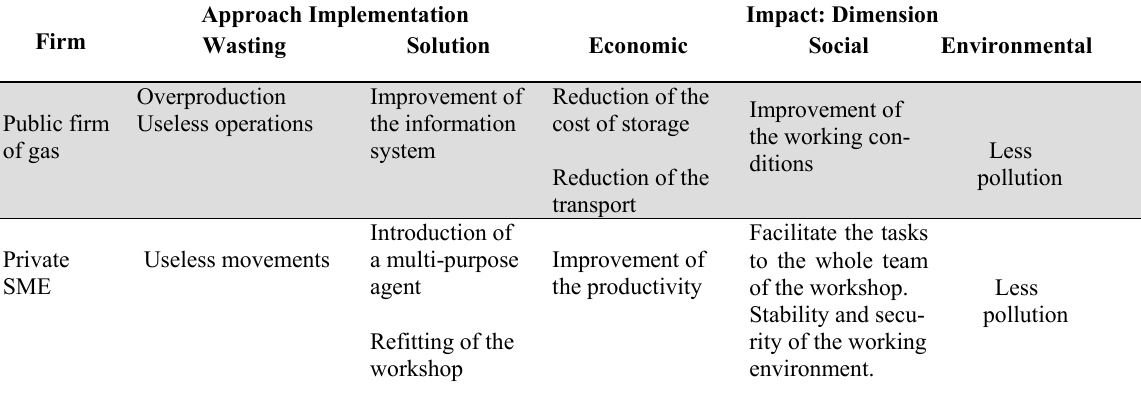
Less pollution Less